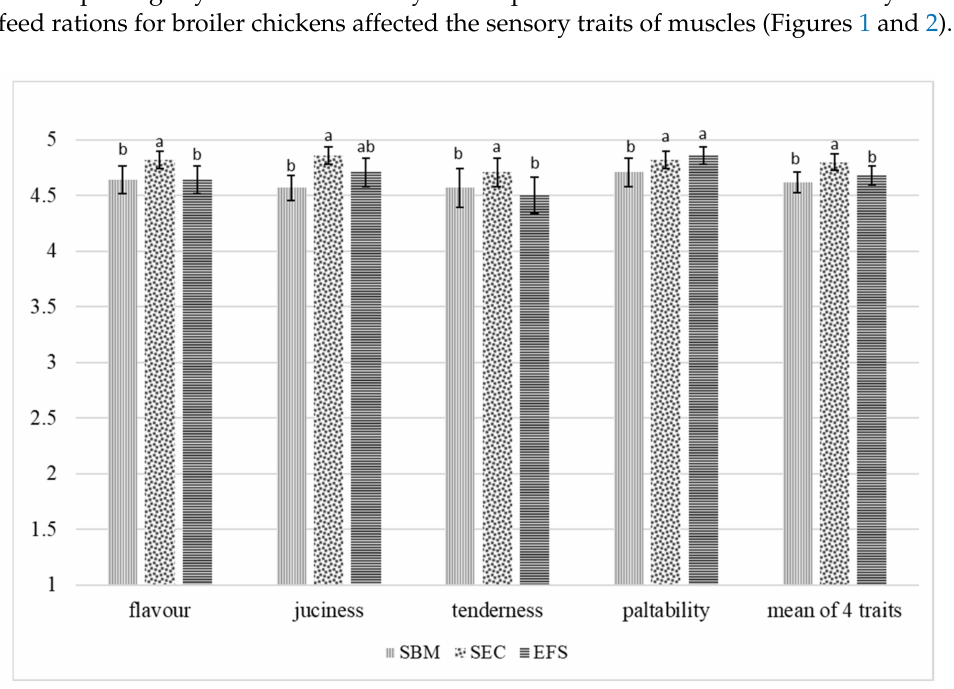
Figure 1. Sensory evaluation of breast muscles (point). a,b—means with different superscripts within a row are significantly different at p <